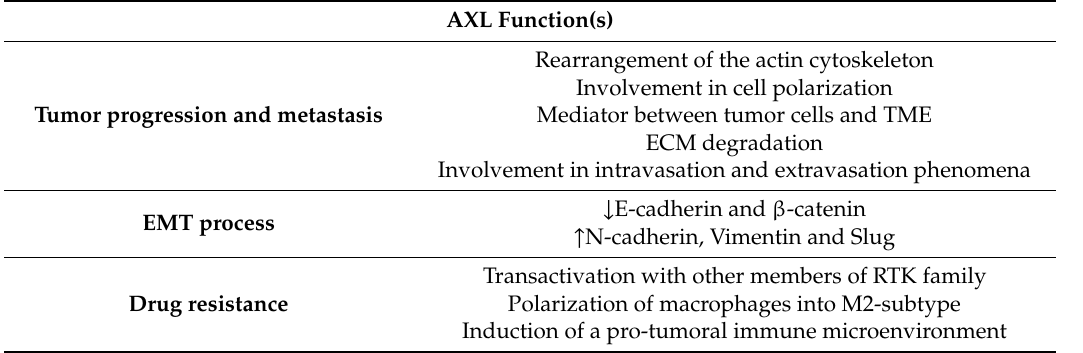
Table 1. AXL involvement into tumorigenesis. Tumor microenvironment (TME); extracellular matrix (ECM); epithelial–mesenchymal transition (EMT); receptor tyrosine kinase